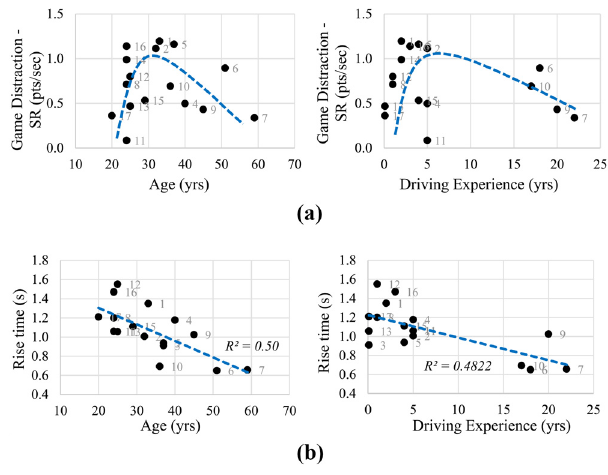
Figure 10 Driver ’ s age and experience (Driver IDs are labeled next to the data